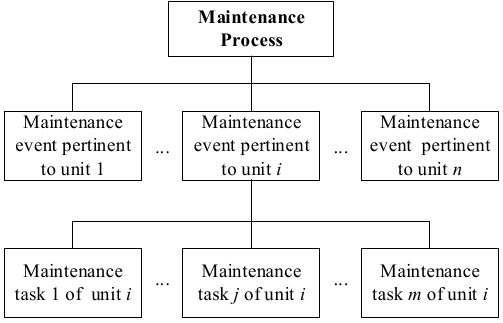
Figure 1. Hierarchical chart of maintenance actions.